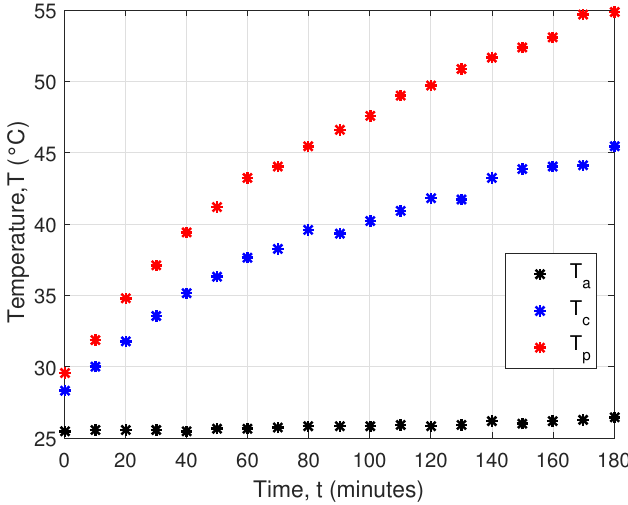
Figure 10. Measured temperatures on the hot and cold sides of Peltier cell.